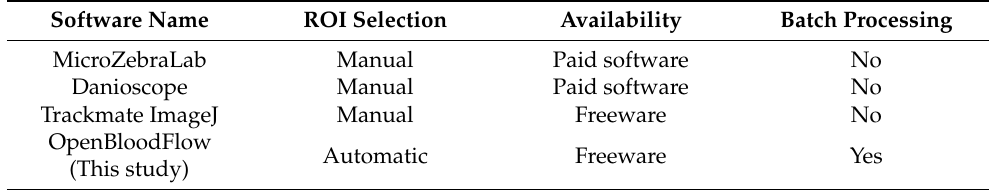
Table 2. Comparison of available software packages to measure blood flow velocity or blood cell count in